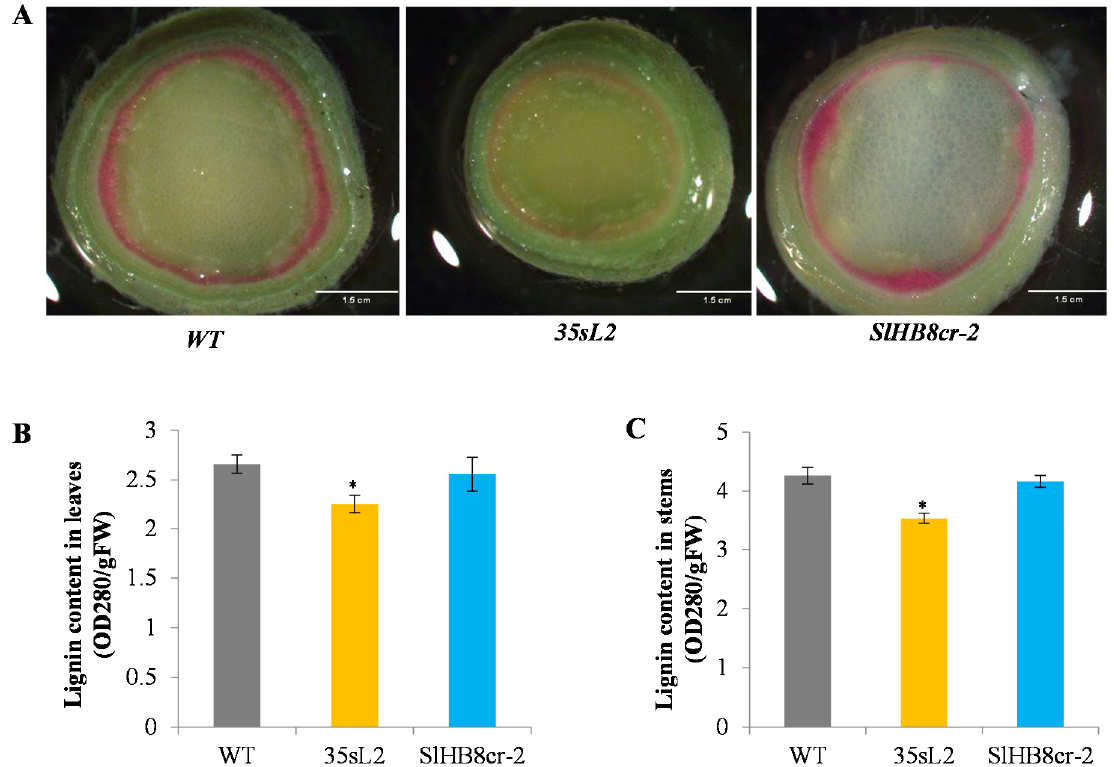
Figure 3. SlHB8 affects lignification in tomato leaves and stems. ( A ) Free-hand sections of the 2-month-old stem were subjected to phloroglucinol-HCl staining. The red area represents lignin. Bars: 1.5 cm. ( B ) Acetyl bromide-soluble lignin assays were carried out on leaves (2-month-old tomato) of SlHB8 overexpression, SlHB8 knock out lines and WT plants. ( C ) The content of lignin in the stems (2-month-old tomato) of SlHB8 overexpression, SlHB8 knock out lines and WT plants was measured by acetyl bromide lignin assay. In the chart of B and C, the gray columns represent the wildtype line, the orange columns represent the 35s-driven SlHB8 overexpression (35sL2) line, and the blue columns represent the SlHB8 knockout (SlHB8-cr2) line Error bars mean ± standard error (SE) value for each line. Stars indicate the statistical significance using Student’s t-test: * p -value < 0.05.